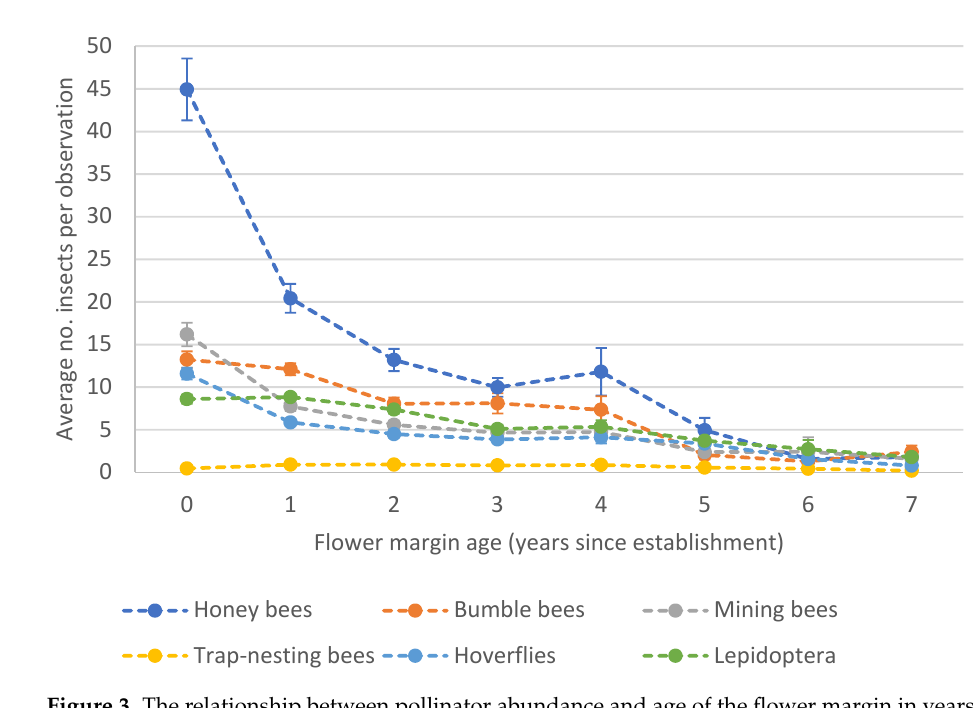
Figure 3. The relationship between pollinator abundance and age of the flower margin in years since establishment.